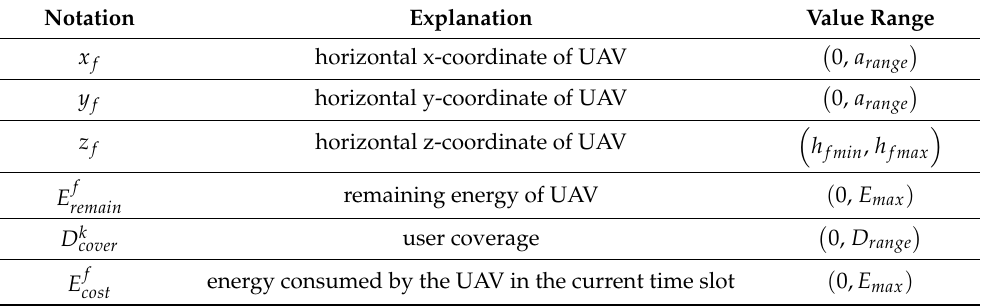
Table 1. Explains the notations, explanations, and value ranges of each quantity in the state